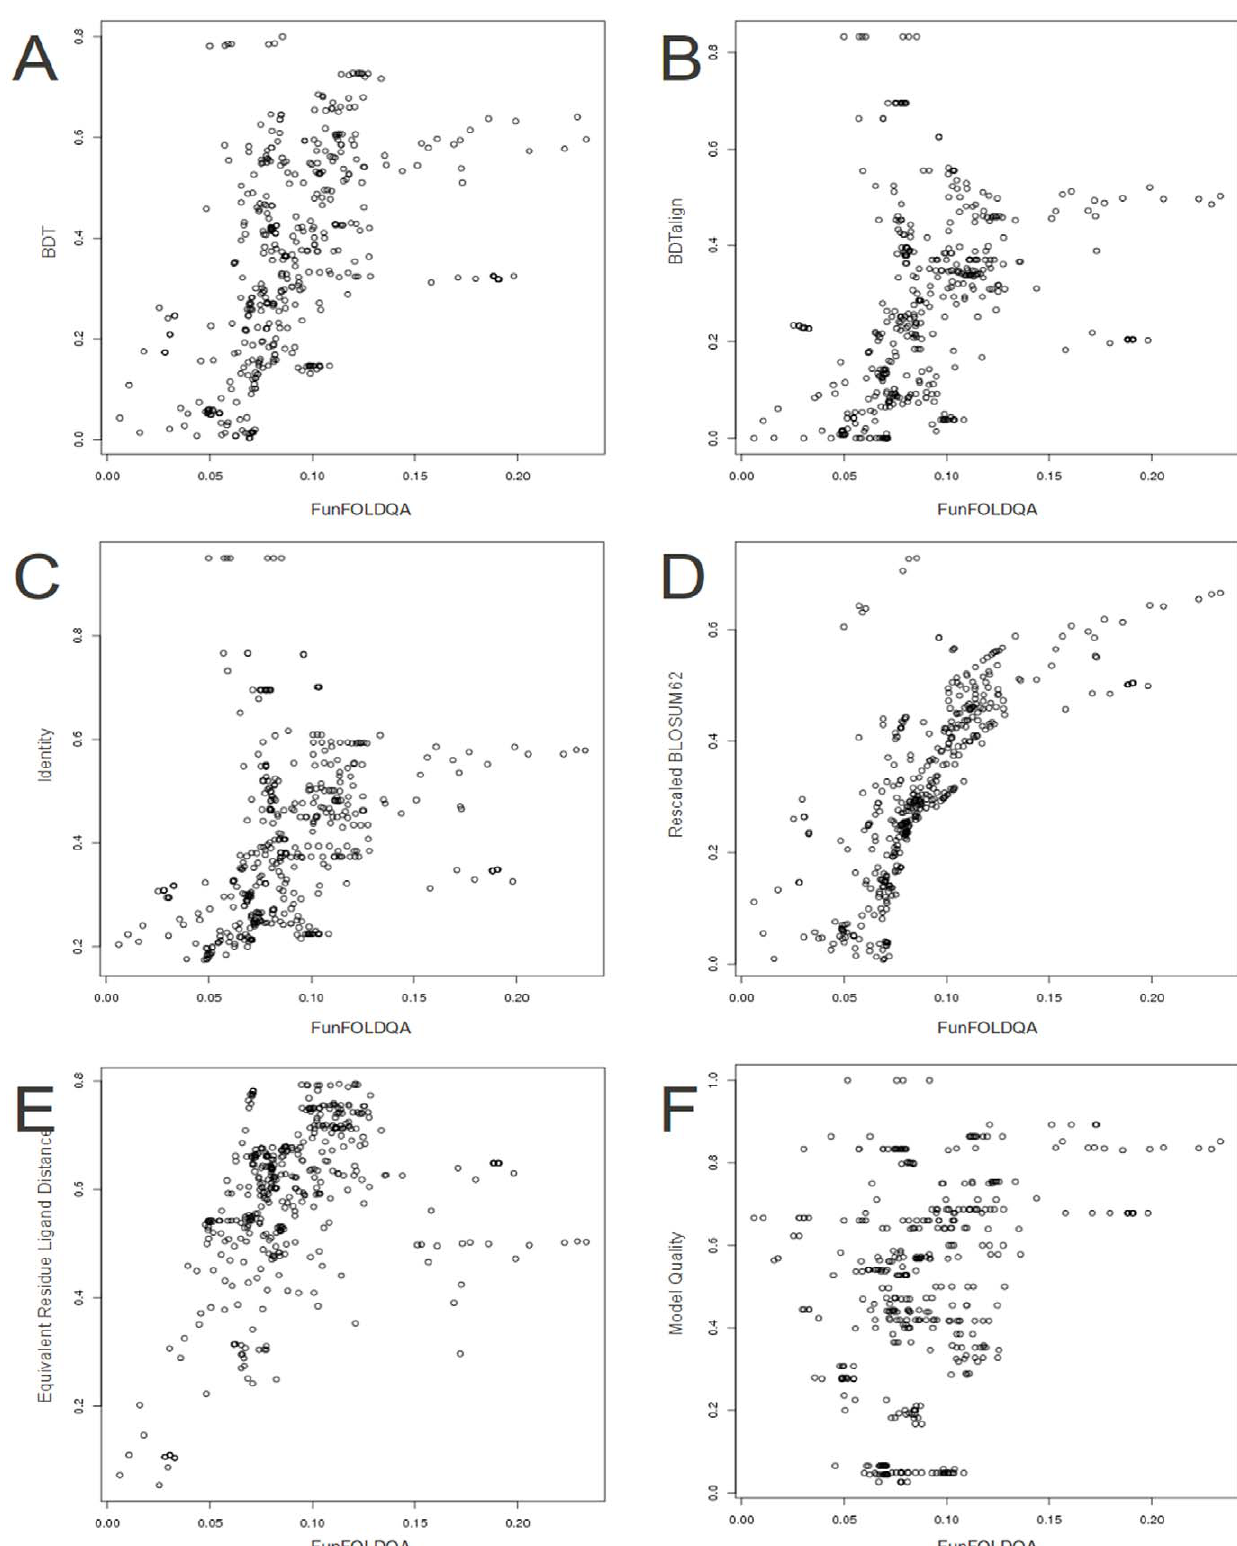
Figure 4. The FunFOLDQA Neural Network scores compared with the observed BDT scores and the feature component scores (CASP8 data). A) The FunFOLDQA Neural Network is plotted against the observed BDT score. B) The BDTalign score. C) The Identity score. D) The Rescaled BLOSUM62 score. E) The Equivalent Residue Ligand Distance score. F) The 3D Model Quality score (ModFOLDclust2).